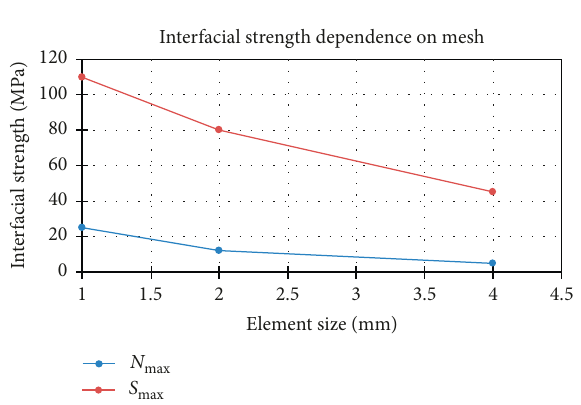
Figure 27: Interfacial strength dependence on in-plane element